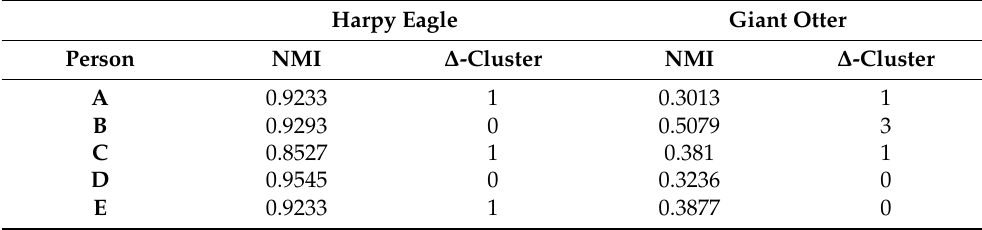
Table 6. NMI and ∆ -Cluster values achieved by inexperienced, human observers compared with the a priori